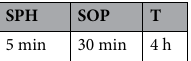
Table 1. Sampling parameters.